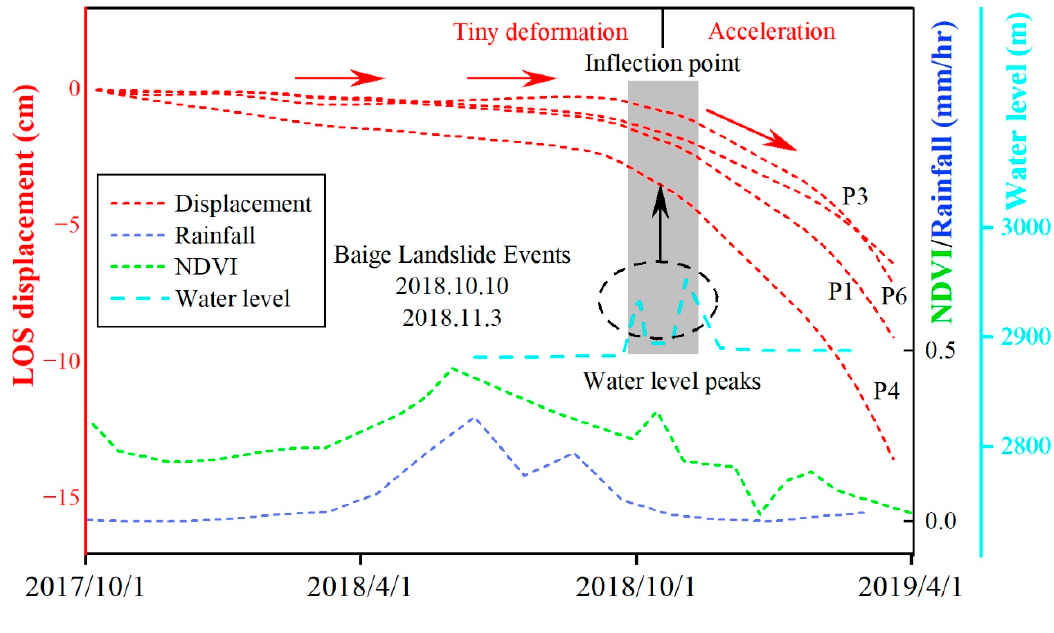
Figure 13. Relationships between landslide deformation and inducing factors.